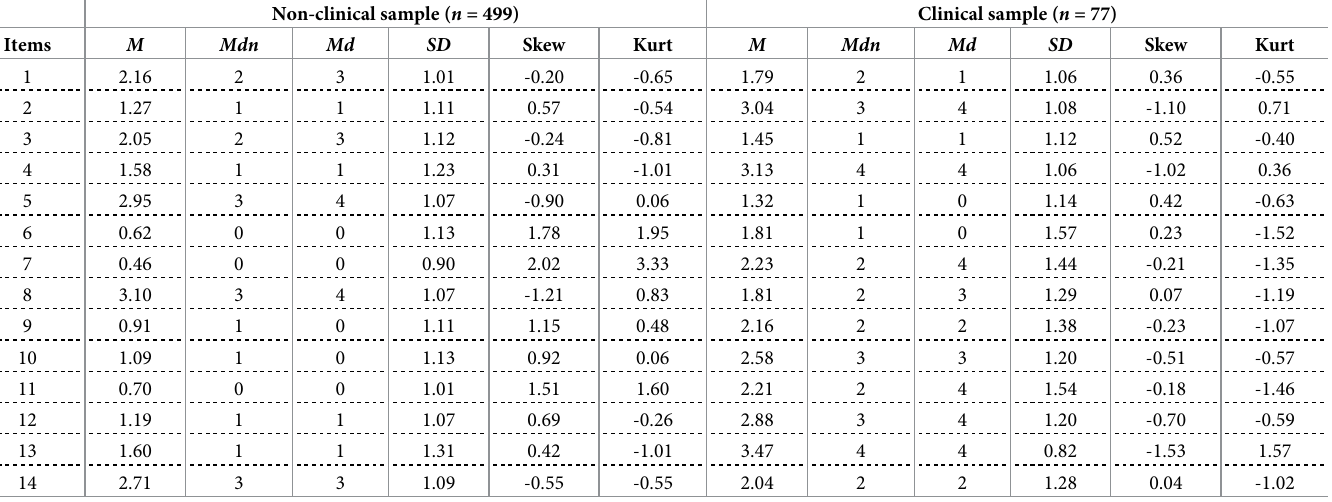
Table 2. Descriptive statistics of the FSCRS-SF items. Non-clinical sample ( n =